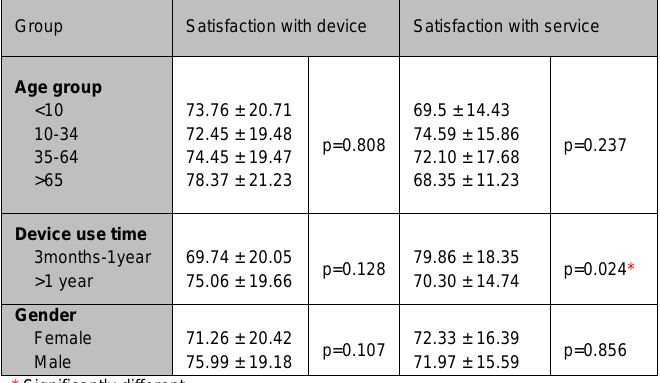
Satisfaction with service Satisfaction with device